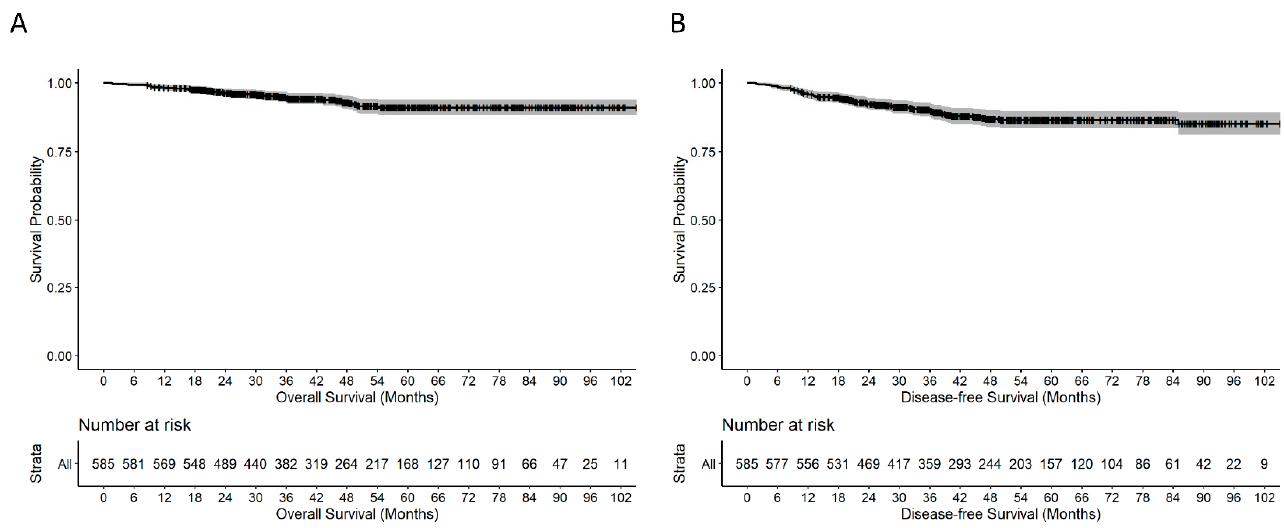
Figure 2. Kaplan–Meier survival curves. ( A ) Overall survival. ( B ) Disease-free survival.